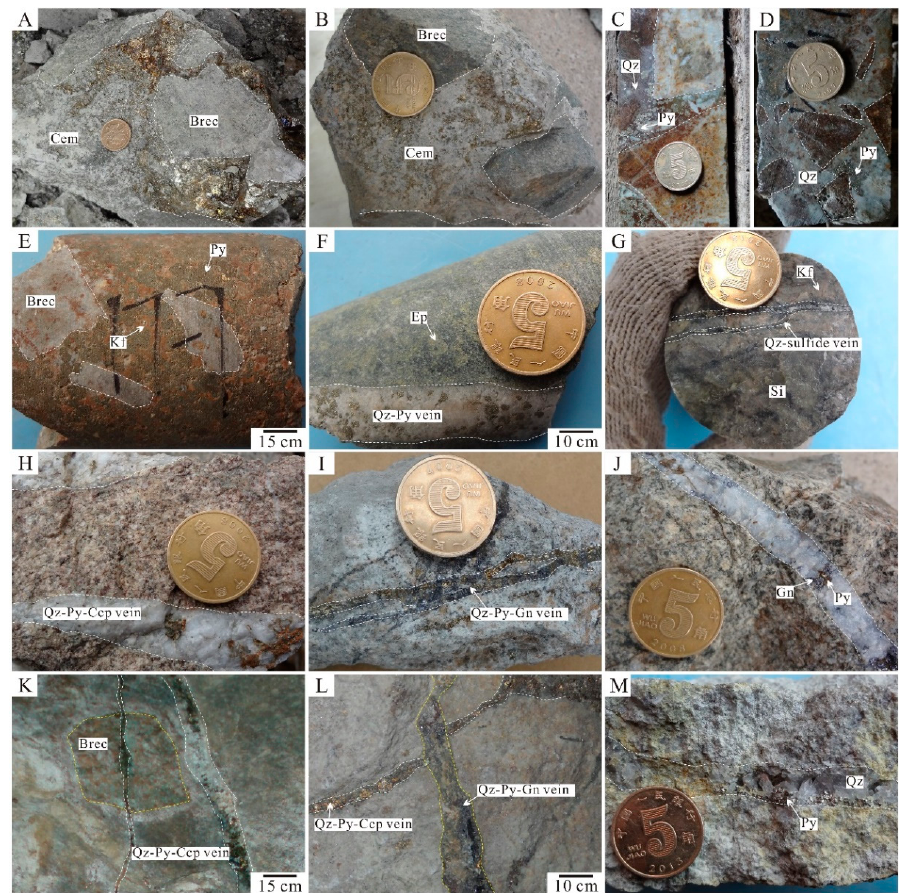
Figure 4. Photographs of ore from the Jinchang gold deposit. ( A – D ) Breccia-hosted ore; ( E ) K-feldspar alteration in the cement of the breccia-hosted ore; ( F ) epidote alteration of the wall-rock surrounding a quartz–pyrite vein; ( G ) silicification of the wall-rock surrounding a quartz–sulfide veinlet; ( H ) quartz–pyrite–chalcopyrite vein; ( I , J ) quartz–pyrite–galena veins; ( K ) breccia-hosted ore crosscut by a